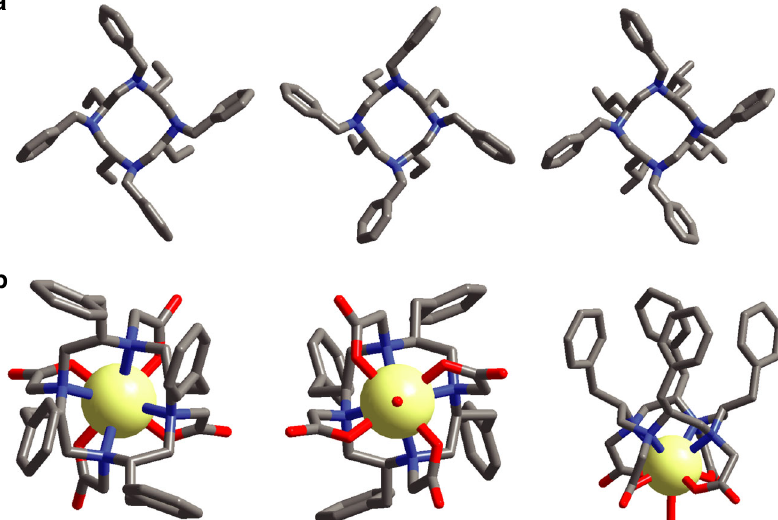
Fig. 2 Crystal structures of ligands 2b, 2c and complex [GdL4] − . a Crystal structure of 2b ( SSSS - λλλλ ), 2b ( SSSS - δδδδ ) and 2c . b Crystal structure of [GdL4] − from top view, bottom view and side view. Atom labels: C (grey), N (blue), and O (red); H atoms omitted for